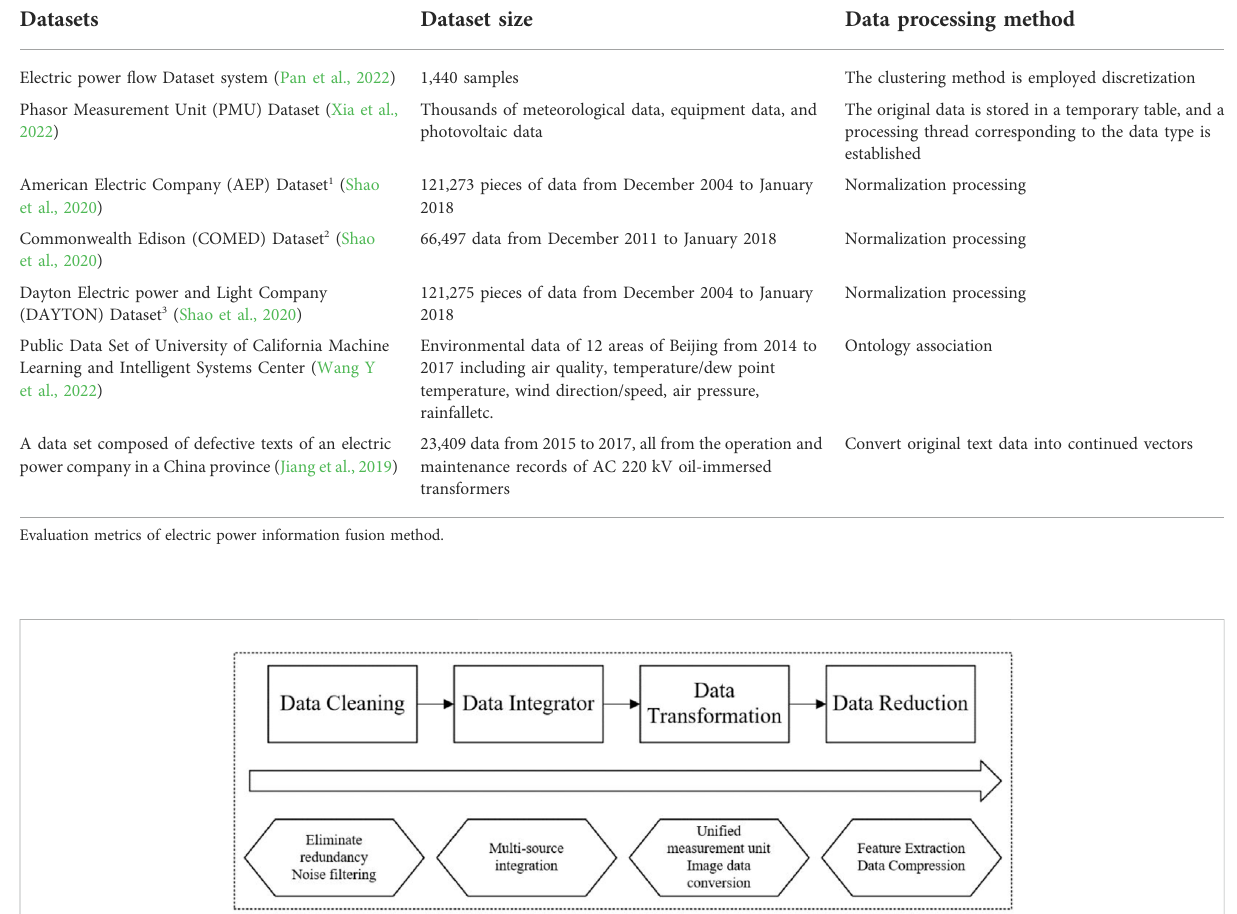
TABLE 5 Datasets and data processing methods.